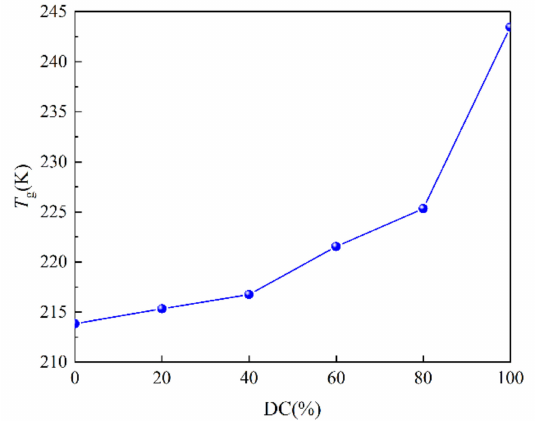
Figure 13. T g of SEUG with different degrees of